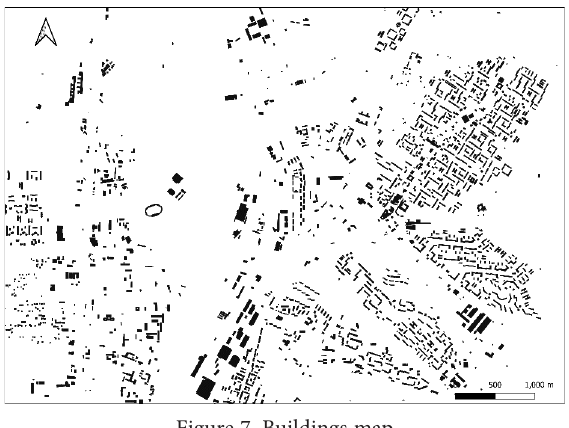
Figure 7. Buildings